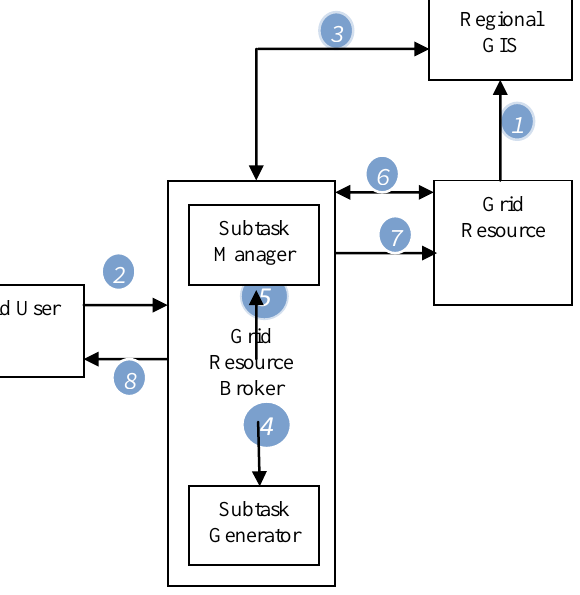
Figure 3. Interaction of different components in the proposed